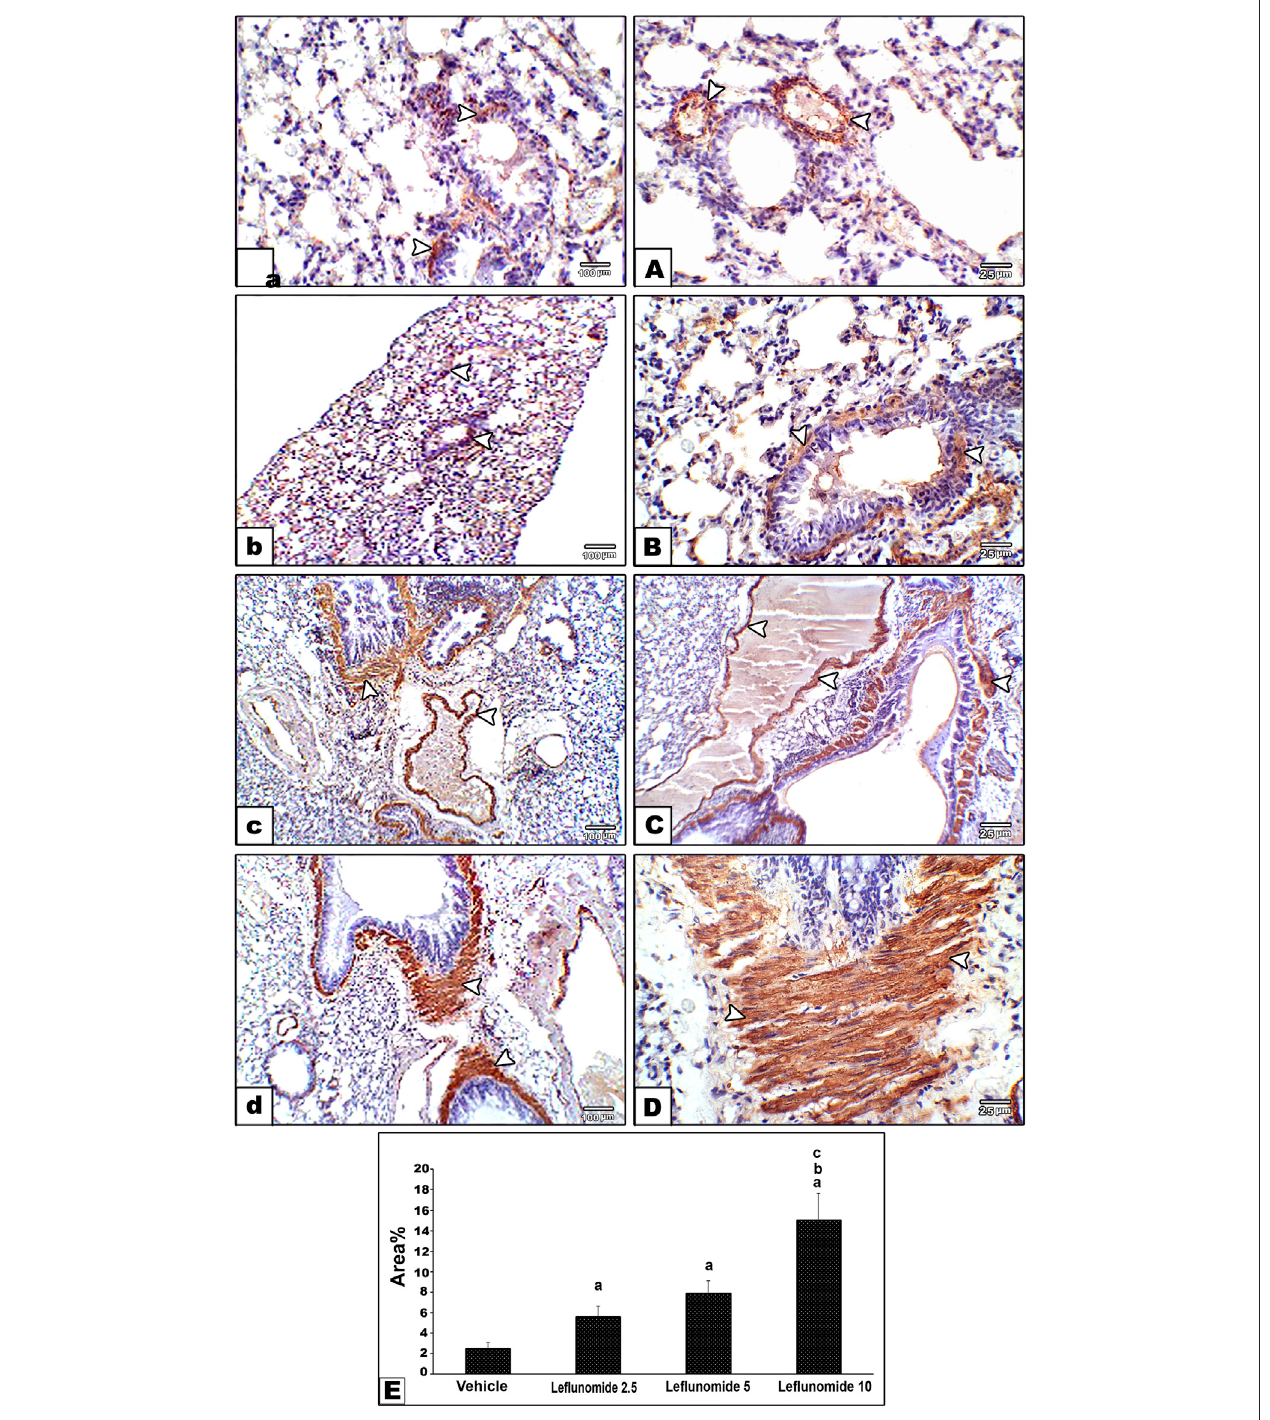
FIGURE7| Immunohistochemicalstainingfor α -smoothmuscleactininlungsections (A) Animagefromthevehiclecontrolgroup(groupI)showsmildcytoplasmic expression of smooth muscle actin antibody in perivascular and peribronchiolar muscle coat with also expression in scattered few mesenchymal cells in interalveolar septa. Compared to its gradually and progressively increased expression in le fl unomide 2.5 group (B) , le fl unomide 5 group (C) and le fl unomide 10 group (D) (E) A columnchartrepresentingthemeanarea ± SDM, (A) :vs.thevehiclegroup, (B) :vs.thele fl unomide2.5 mgperkggroup, (C) :vs.thele fl unomide5 mgperkggroup at p <